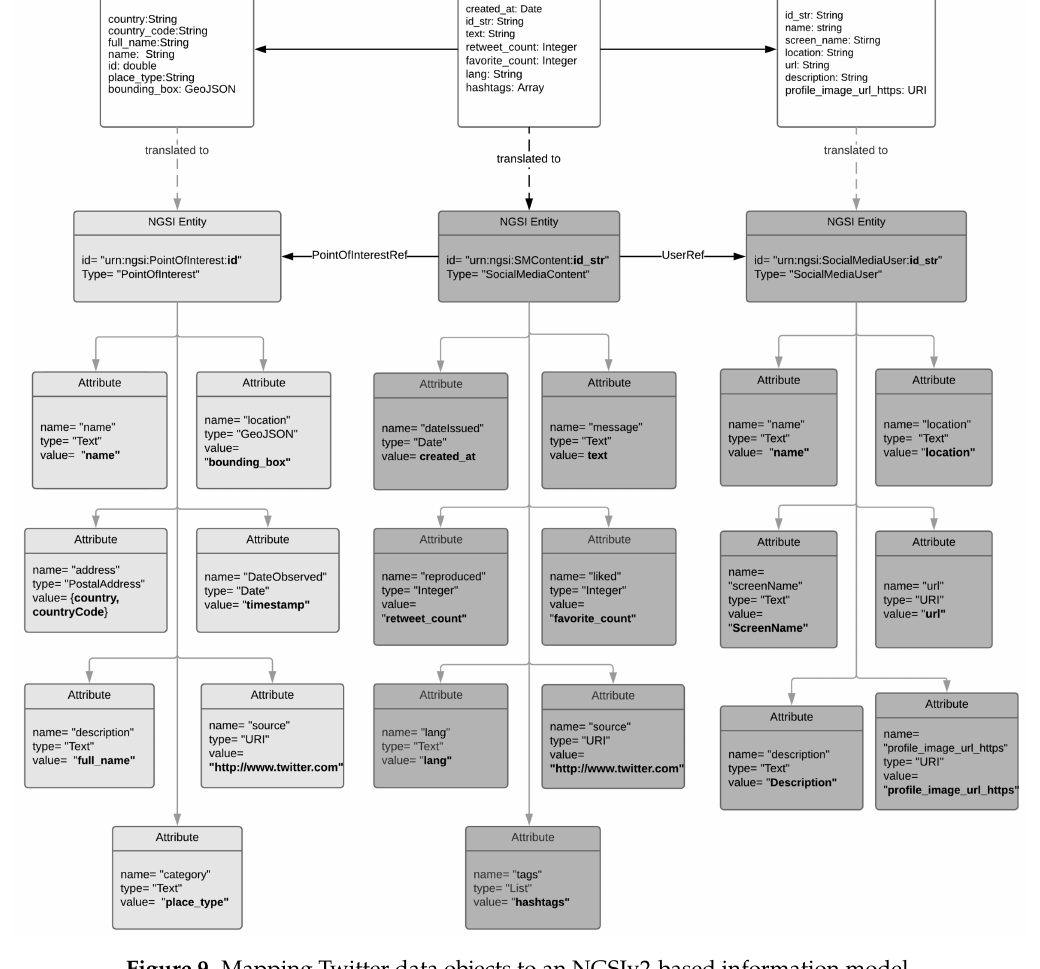
Figure 9. Mapping Twitter data objects to an NGSIv2-based information